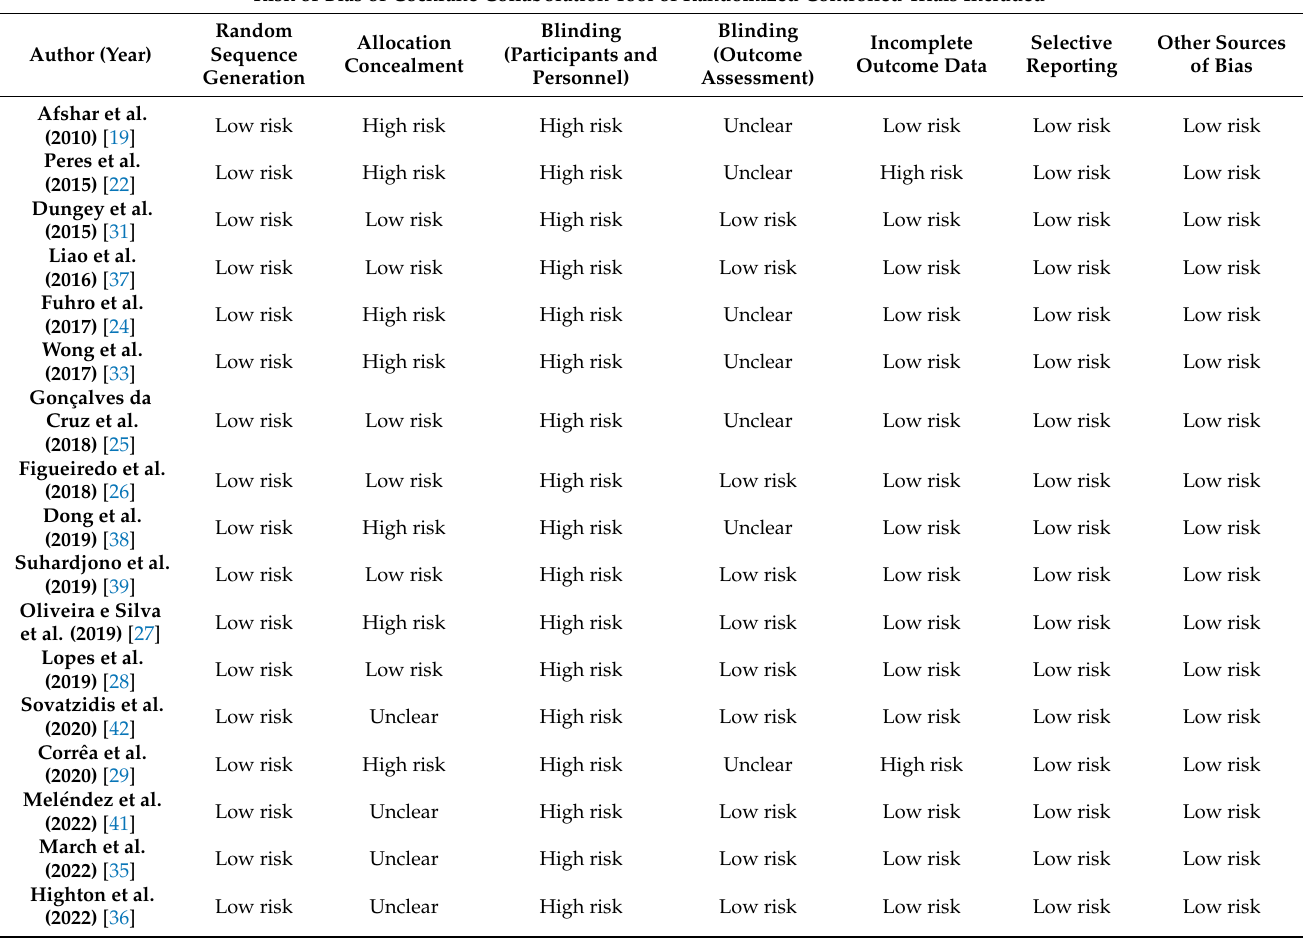
Table 3. Methodological quality evaluation of the clinical trials using the Cochrane Risk of Bias Tool for assessing the risk of bias in randomized